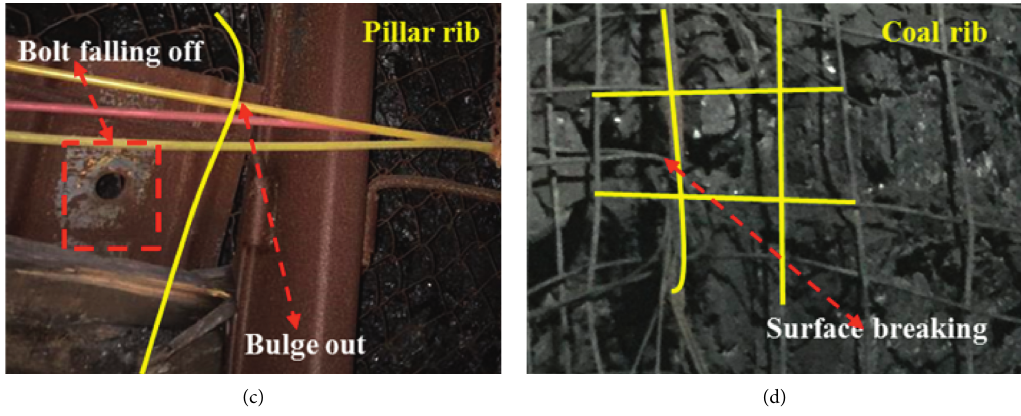
Figure 4: Mine pressure appearance of roadway.